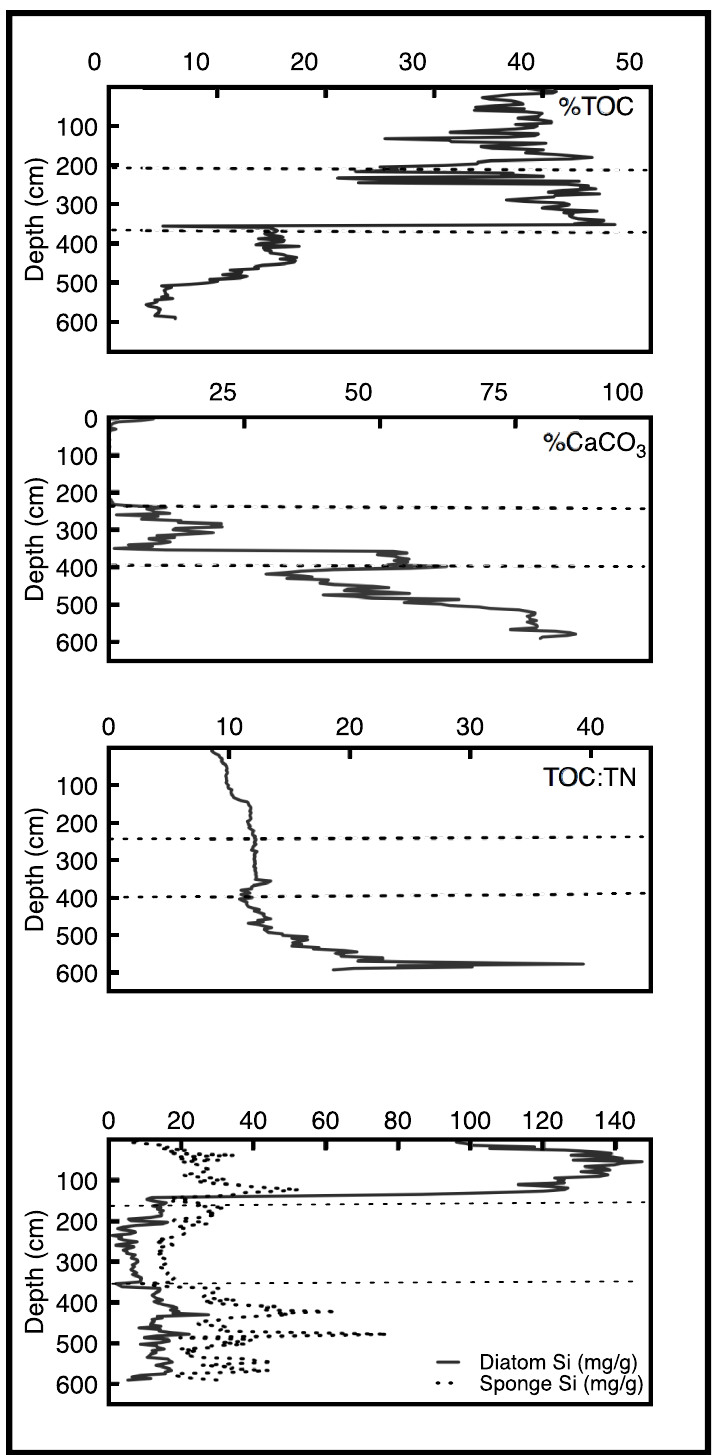
Fig 3. Bulk geochemical variability in the Lake Harris core. From the top panel to the bottom: percent total organic carbon, percent calcium carbonate, molecular total organic carbon to total nitrogen, and diatom and sponge derived silica